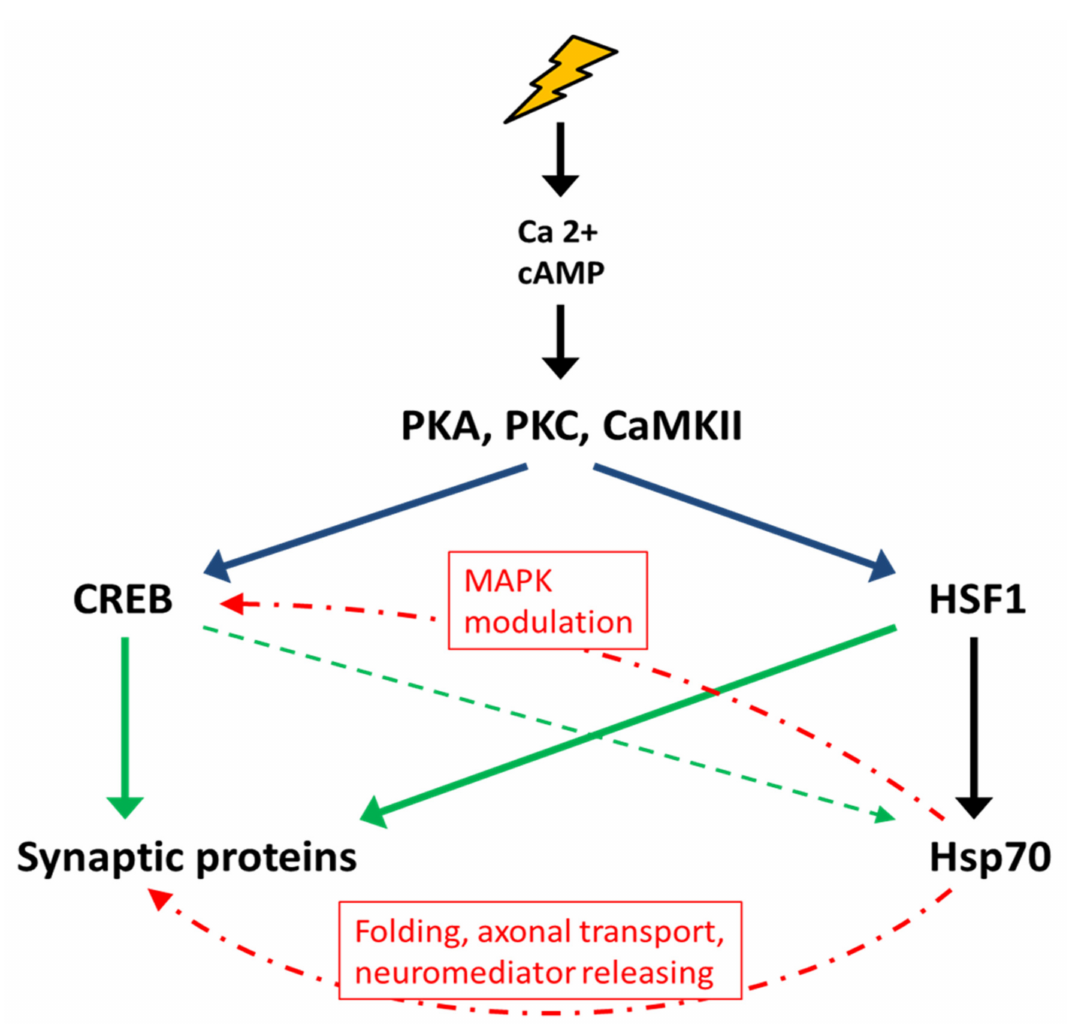
Figure 4. Interactions between the stress response and memory formation. Stress stimuli lead to an increase in the concentration of calcium and cAMP in the cytosol in CNS cells and the activation of protein kinases PKA, PKC, CaMKII, etc., which are involved in the regulation of the activity of transcription factors, in particular, CREB and HSF1. Both CREB and HSF1 initiate the transcription of genes encoding synaptic proteins and Hsp70. In turn, Hsp70 promotes the folding and transport of synaptic proteins and the release of neurotransmitters, activates the MAPK signaling cascade, and ensures the structural integrity of synapses by interacting with the